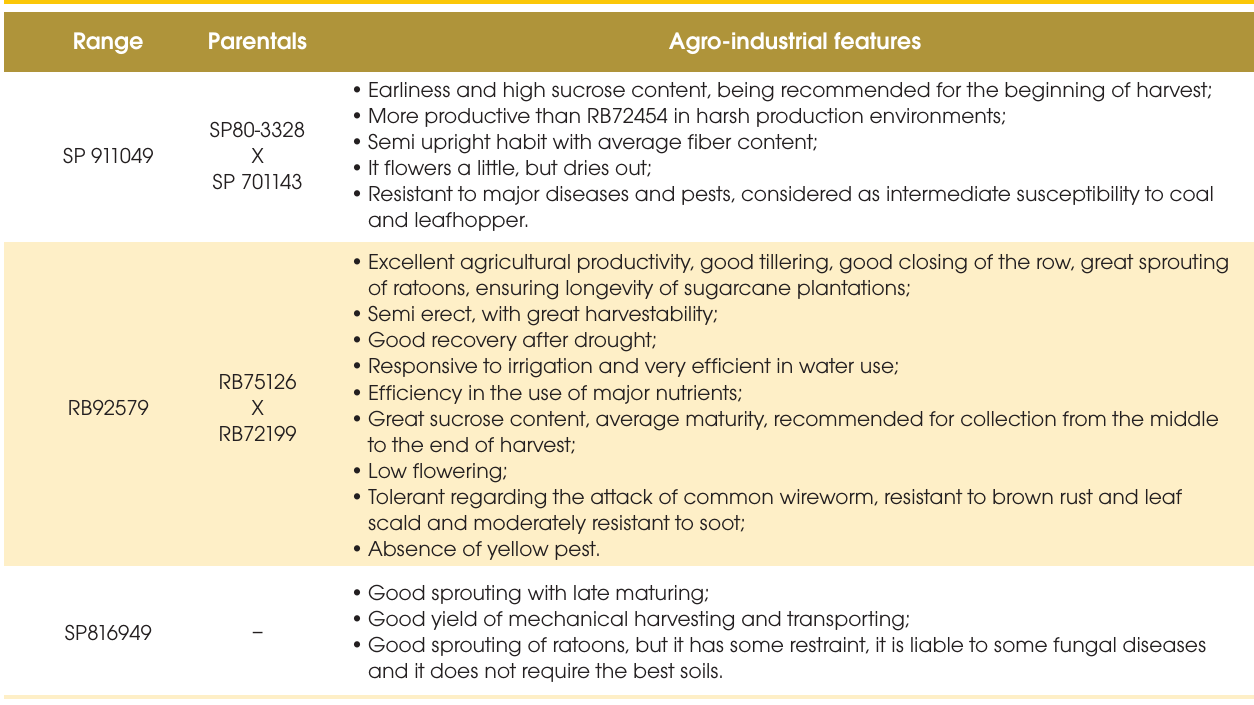
Table 1 – Range of sugarcane and their agro-industrial features used in work Range